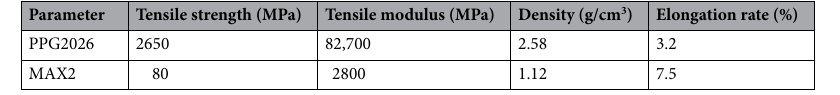
Table 1. The property parameters of